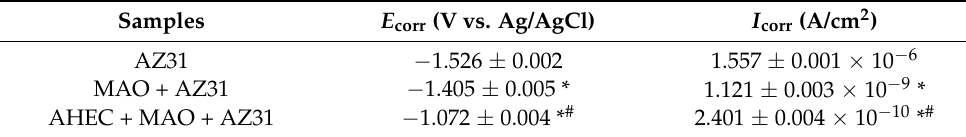
Table 3. Relative electrochemical parameters (mean ± standard deviation).